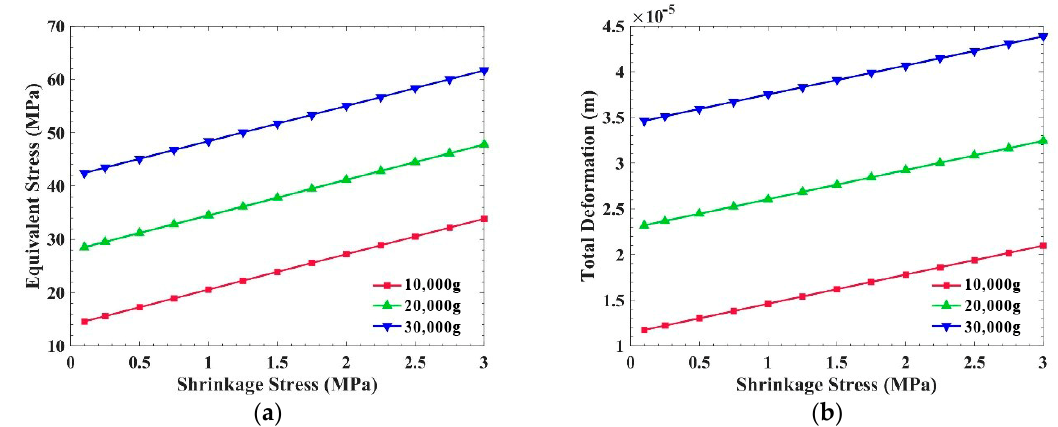
Figure 7. Influence of shrinkage stress on the PCB, which is perpendicular to the overload direction: ( a ) Equivalent stress of the PCB; ( b ) Total deformation of the PCB.